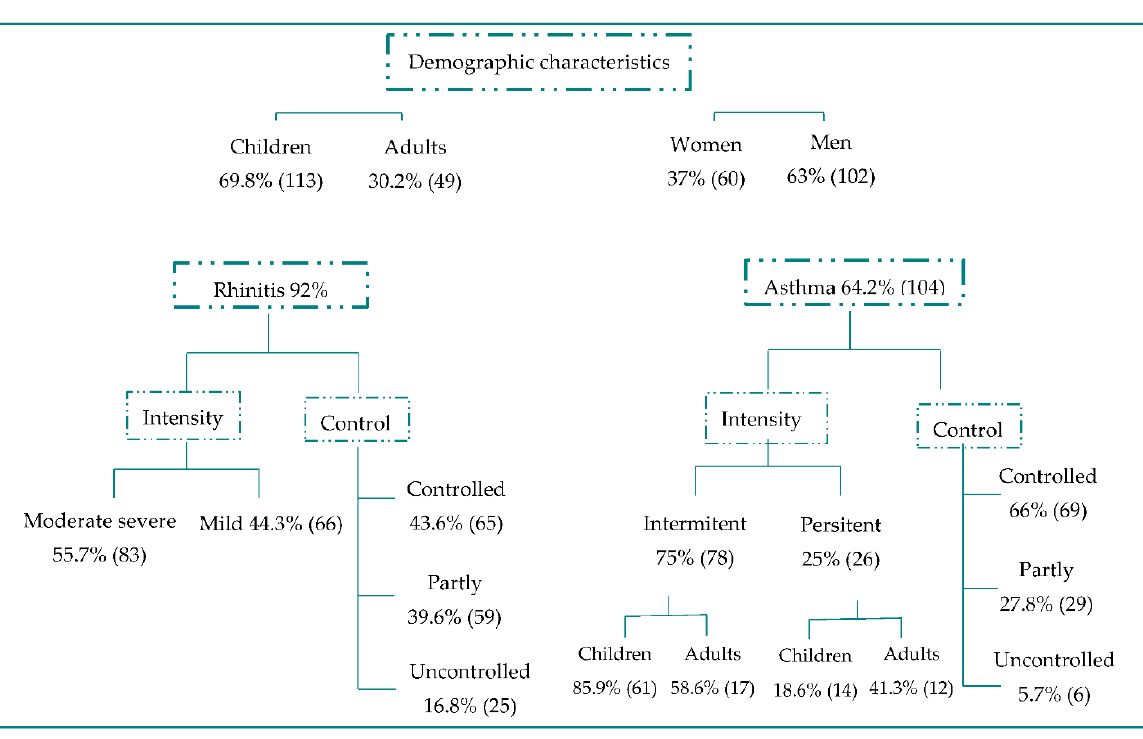
Figure 4. Characteristics of patients sensitized to Alternaria alternata and Alt a 1. In total, 113 (69.8%) of the children were sensitized to Alternaria alternata and Alt a 1 and 49 (30.2%) of adults. There was a significant ( p = 0.0387) difference between the percentage of children sensitized to Alternaria alternata and that of those non-sensitized. In total, 102 (63%) of patients sensitized to Alternaria alternata and Alt a 1 were men; a significant difference ( p = 0.0292) (2:1 male: female) was found between those sensitized to Alternaria alternata and those who were not.